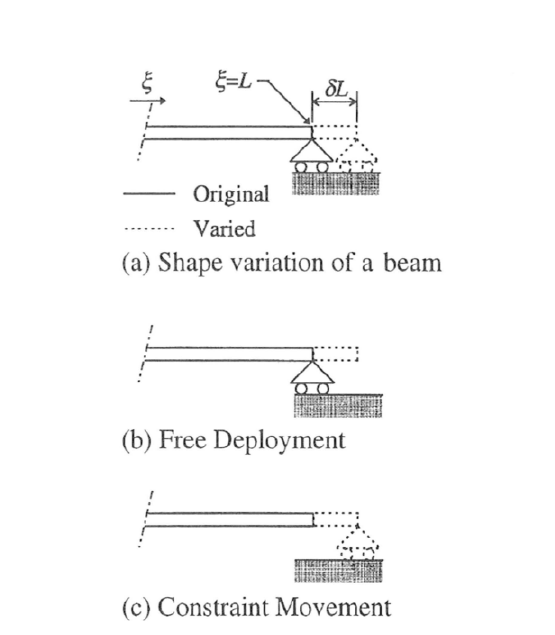
FIGURE 1 Assumptions on the shape variation of a